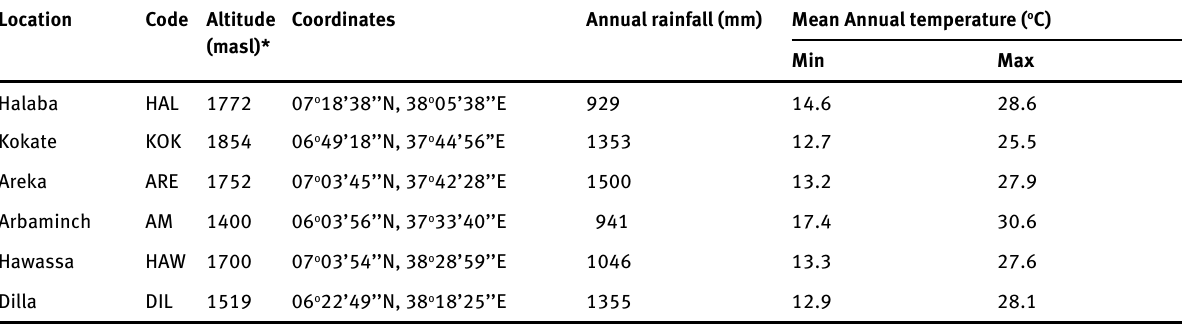
Table 1: Description of the experimental areas Location